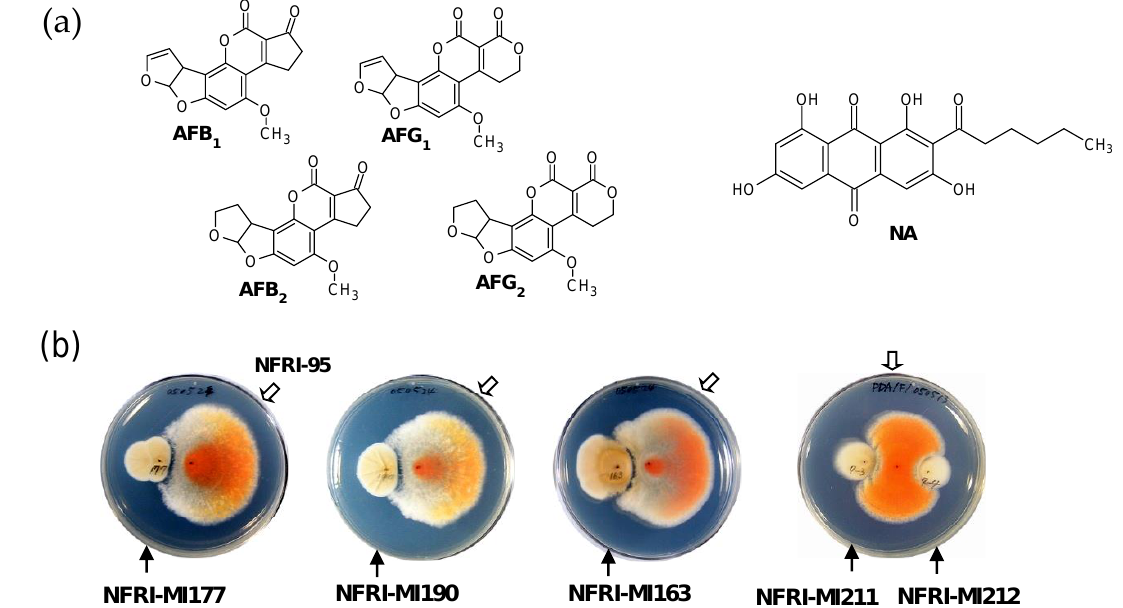
Figure 1. Inhibition of A. parasiticus strain NFRI-95’s accumulation of norsolorinic acid (NA) by isolated fungi: ( a ) Structures of the major AFs (AFB 1 , AFB 2 , AFG 1 , and AFG 2 ) and NA, which has a bright red color; ( b ) the inhibition of strain NFRI-95’s NA production by isolated fungi. Spores of the isolated fungus (solid arrows) and spores of NFRI-95 (open arrows) were inoculated and cultured on the same plate. The accumulation of the red pigment (NA) of the NFRI-95 colony was examined from the underside of each plate. Fungi named NFRI-MI177, -MI190, and -MI163, but not NFRI-MI211